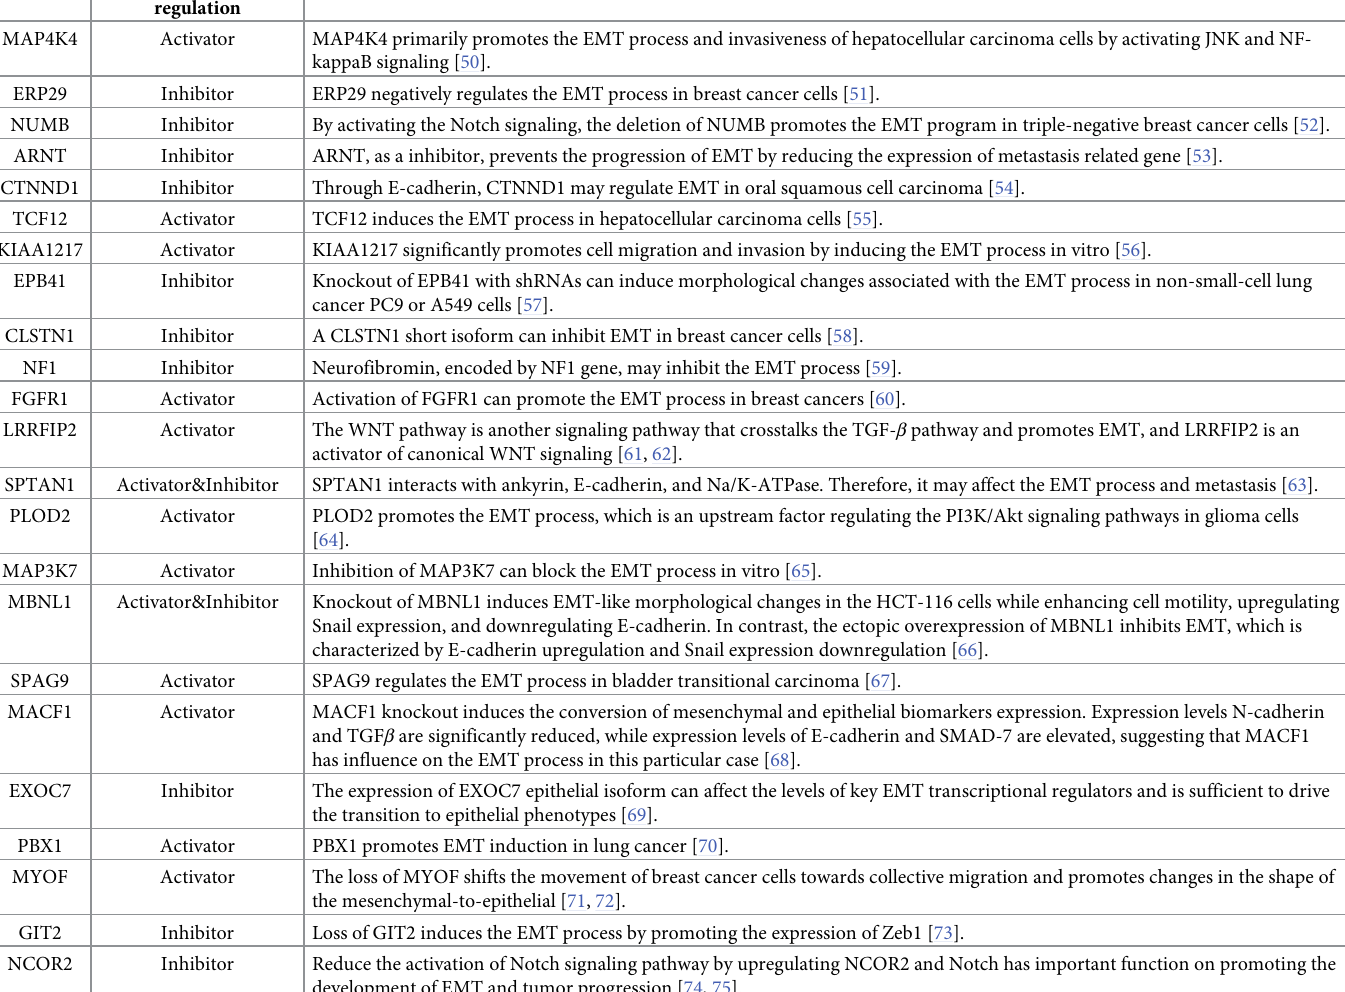
Table 2. Genes reported in previously published literature. Gene EM transition regulation